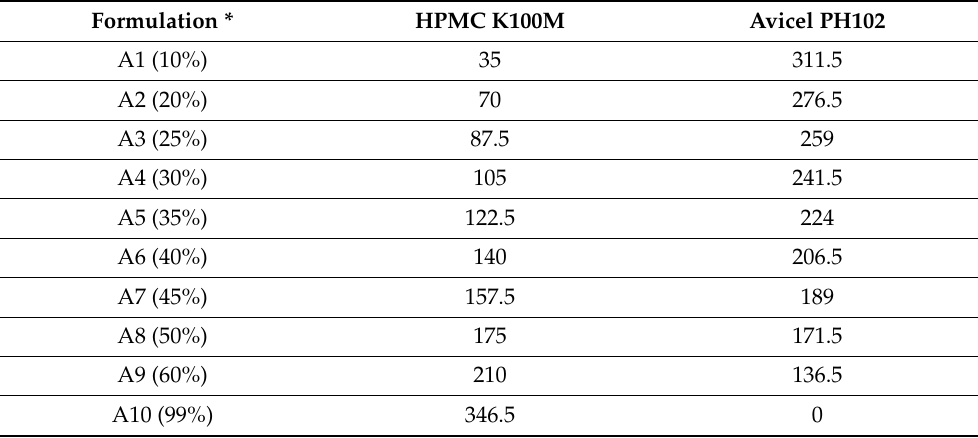
Table 13. The formulations of A1 to A10.